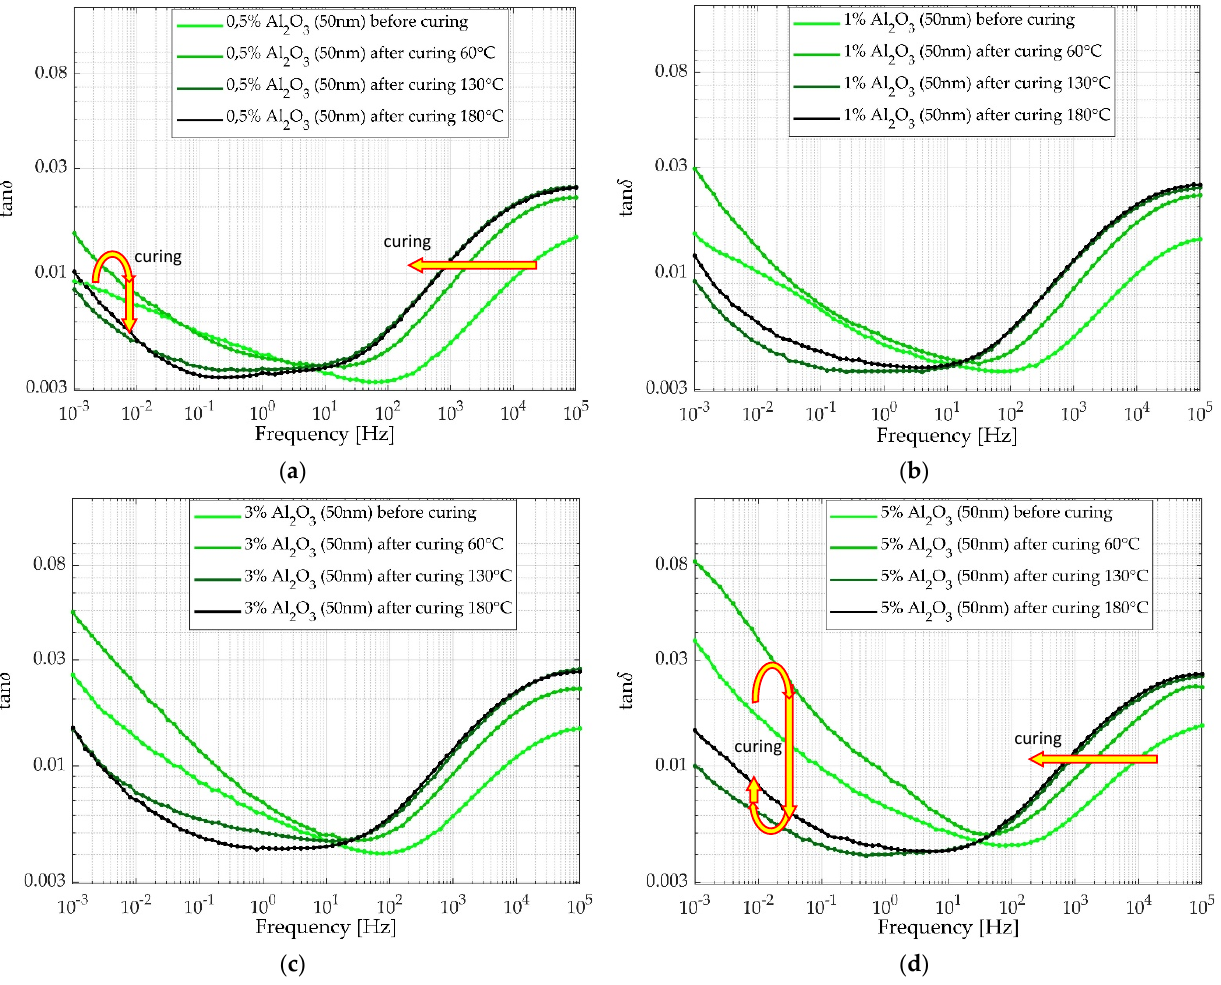
Figure 10. Broadband dielectric loss factor tan δ ( f ) characteristics for samples with Al 2 O 3 , with particles of 50 nm and different wt%: ( a ) 0.5%, ( b ) 1%, ( c ) 3%, ( d ) 5%.